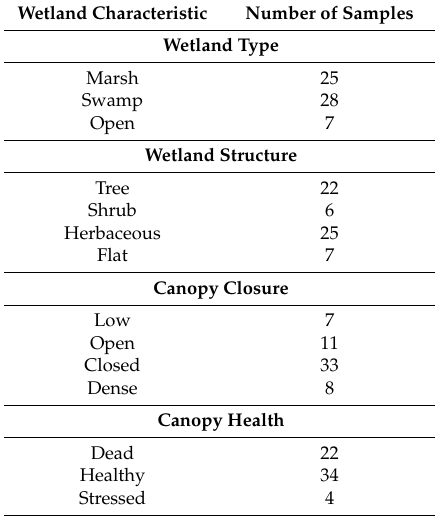
Table 2. Sample numbers for the different types of wetlands and their